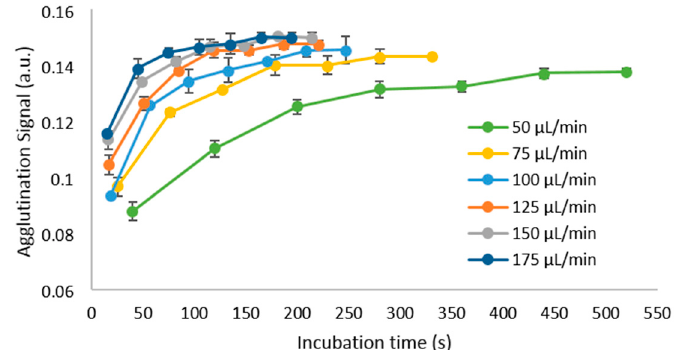
Figure 4. Effect of increasing the flow rate of the system, using a concentration of 2.5 µg/mL biotinylated BSA, as the plugs travel through the tube. Each data point represents the average of 15 measurements, and the error bars show the standard deviation between them.